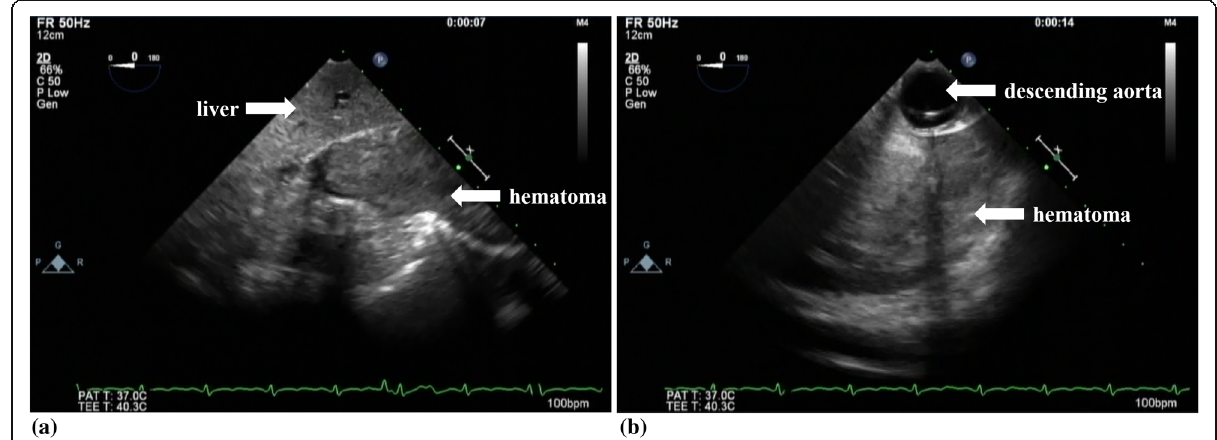
Fig. 2 Hematoma in the left thoracic cavity at the level of the diaphragm. Hematoma is observed at the level of the liver ( a ). A giant hematoma is visualized in the left thoracic cavity behind the descending aorta ( b